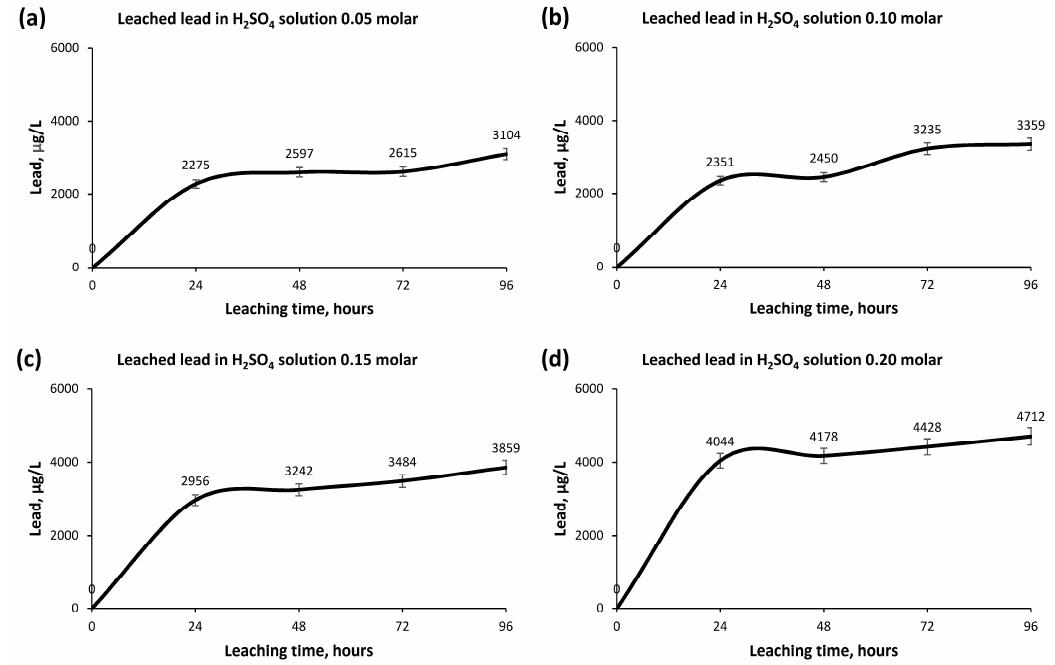
Figure 10. Analysis of Lead concentration in the leaching process at atmospheric pressure, ambient temperature and in different Sulphuric Acid solutions: ( a ) 0.05 molar H 2 SO 4 solution, ( b ) 0.10 molar H 2 SO 4 solution, ( c ) 0.15 molar H 2 SO 4 solution and ( d ) 0.20 molar H 2 SO 4 solution.